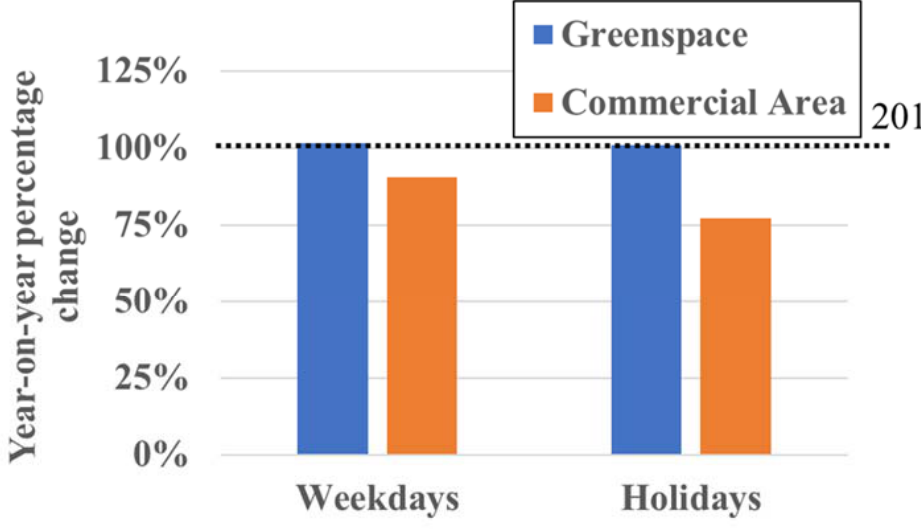
Figure 7. Percentage change by destination in 2020 compared to 2019.